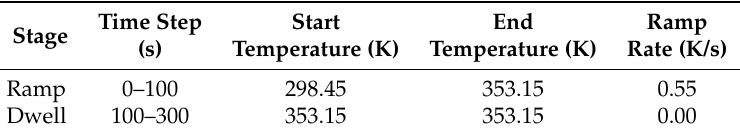
Table 2. Step heating profile for heat zone set